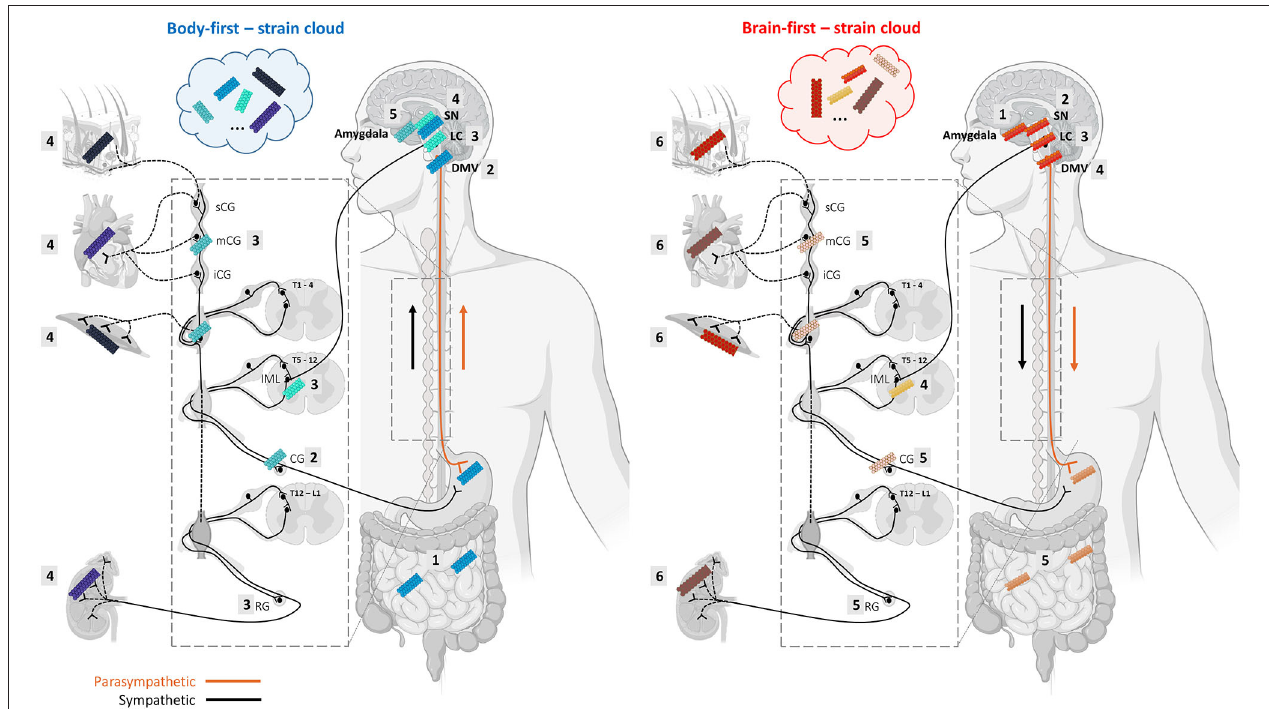
FIGURE 2 | Alpha-synuclein strains may change morphology during trans-synaptic spread along the body-brain axis, resulting in a mix of different conformers in body-first and brain-first LBDs. Monomeric asyn can adopt different β -sheet-rich conformations depending on which conformation is favored by the cellular milieu, which is defined by a certain cell-type and organ where the seeding takes place. The changing cellular environment during trans-synaptic spread along the body-brain axis may give rise to the formation of different asyn conformers throughout the connectome, and even within a single organ. Thus, despite strain characteristics appear to be linked to a certain LBD-subtype, heterogeneity within a subtype may be caused by different dominating strains in their “strain cloud”. The numbered squares indicate the stages of pathology progression throughout the ANS in body-first (left) and brain-first (right) LBD. We speculate that body-first LBD may give rise to a more variable strain cloud, since pathology can initiate in any peripheral organ and enter the brain via parasympathetic as well as sympathetic connections. This might explain why body-first LBDs exhibit distinct disease profiles within (i.e., typical body-first PD, DLB, and PAF). Importantly, propagation of pathology may occur bidirectionally, possible creating even more strain variations (Created with